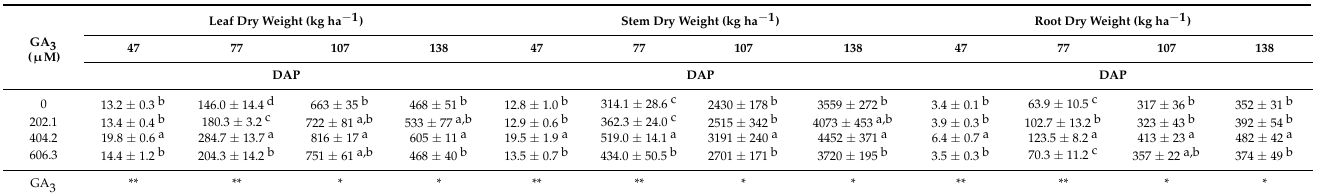
Figure 1. The effects of GA 3 level on the height and root length of sesbania pea at four growing dates grown in saline soils. Within each group, the data marked with different letters are statistically different at the 0.05 probability level. Table 2. The effects of GA 3 level on the leaf dry weight, stem dry weight and root dry weight of sesbania pea at four growing dates grown in saline soils.